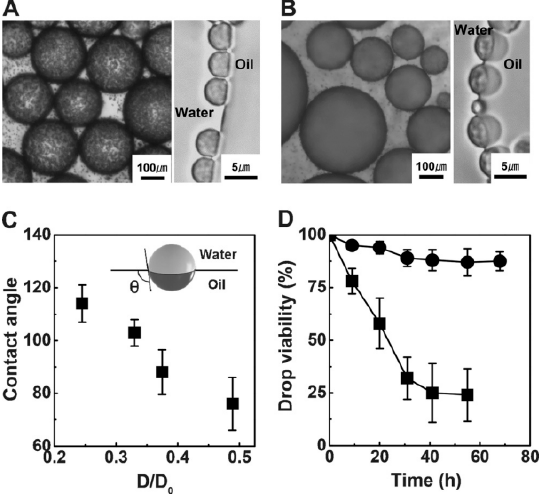
Figure 16. Bright-field microscopy images of the Pickering emulsions stabilized by silica-NP-patched Janus particles with the different degrees of Janusity: ( A ) D/D 0 = 0.25; and ( B ) D/D 0 = 0.5. The inset images show adhesion of amphiphilic Janus particles at the hexadecane–water interface; ( C ) Contact angles of silica NP-patched Janus particles at the hexadecane–water interface; ( D ) Viability of Pickering emulsion drops at 50 °C: D/D 0 = 0.25 ( ■ ) and D/D 0 = 0.5 ( ● ). Reprinted with permission from [135]. Copyright 2016, WILEY-VCH Verlag GmbH & Co. KGaA, Weinheim, Germany.